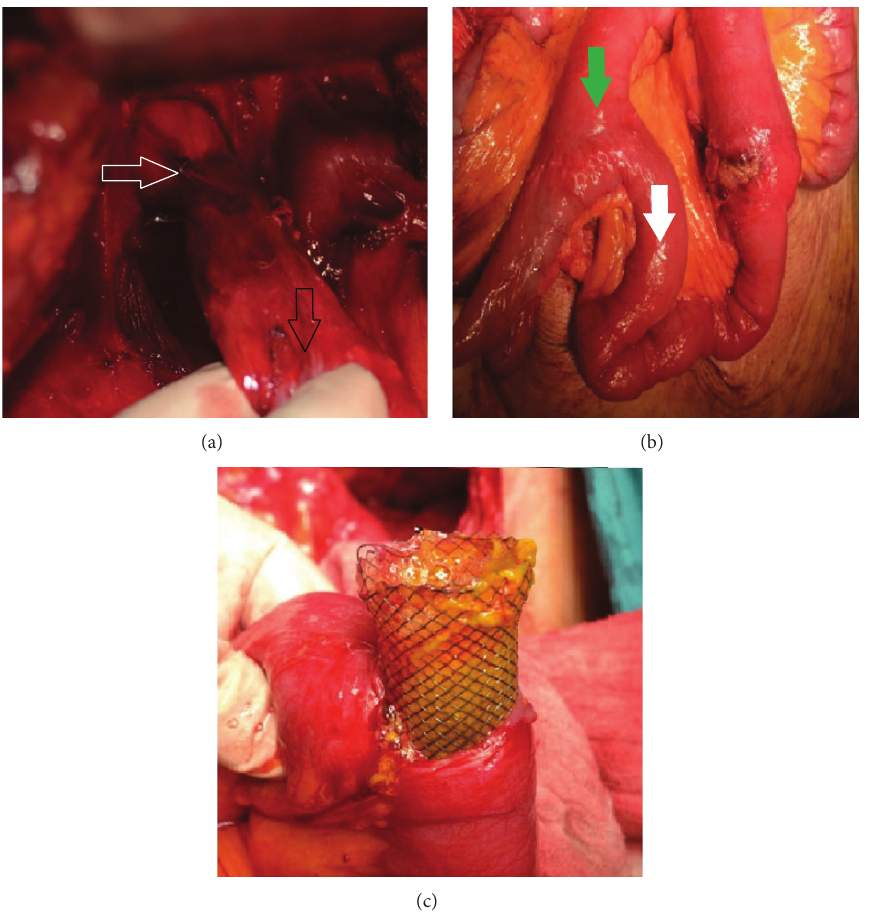
Figure 6: Intraoperative aspects: (a) circumferential distal esophageal stenosis (white arrow), site of esophagojejunal anastomosis (black arrow); (b) migrated stent: direction of migration (white arrow), end-loop proximal small bowel (green arrow); (c) metallic stent into the jejunal